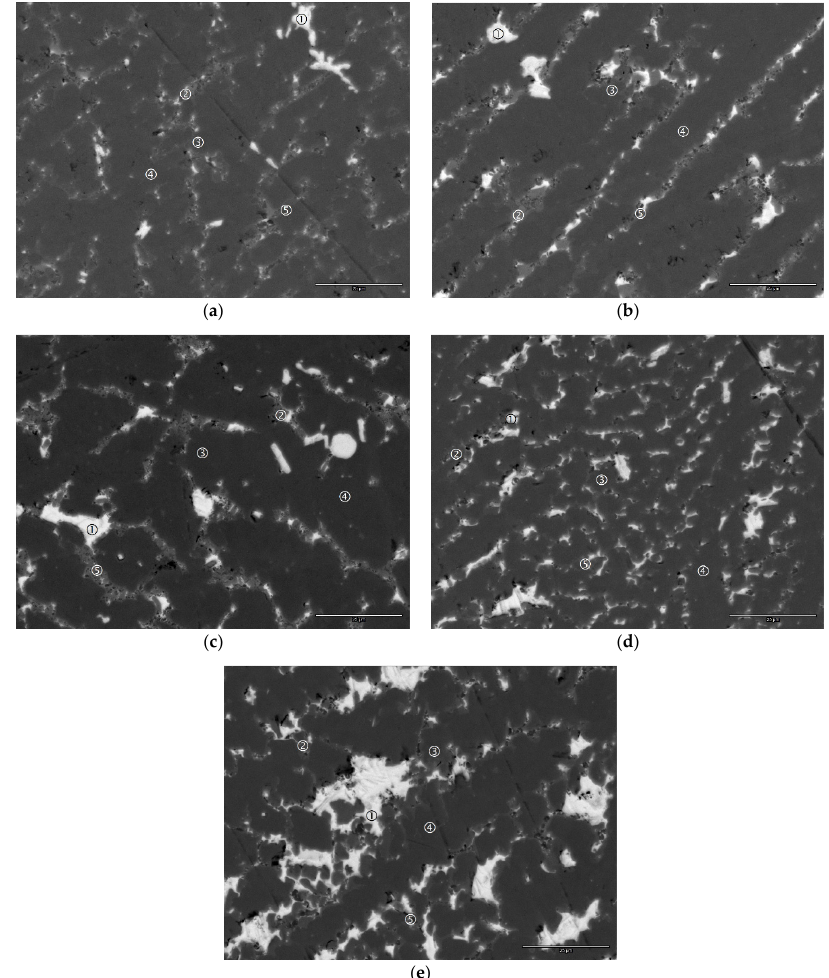
Figure 5. Scanning electron microscope (SEM)-back-scattering electron images (BEI) micrographs from alloys: ( a ) Ce1; ( b ) Ce2; ( c ) Ce3; ( d ) Ce4; and ( e ) Ce5. The bar at the lower right corner represents a scale of 25 μ m.